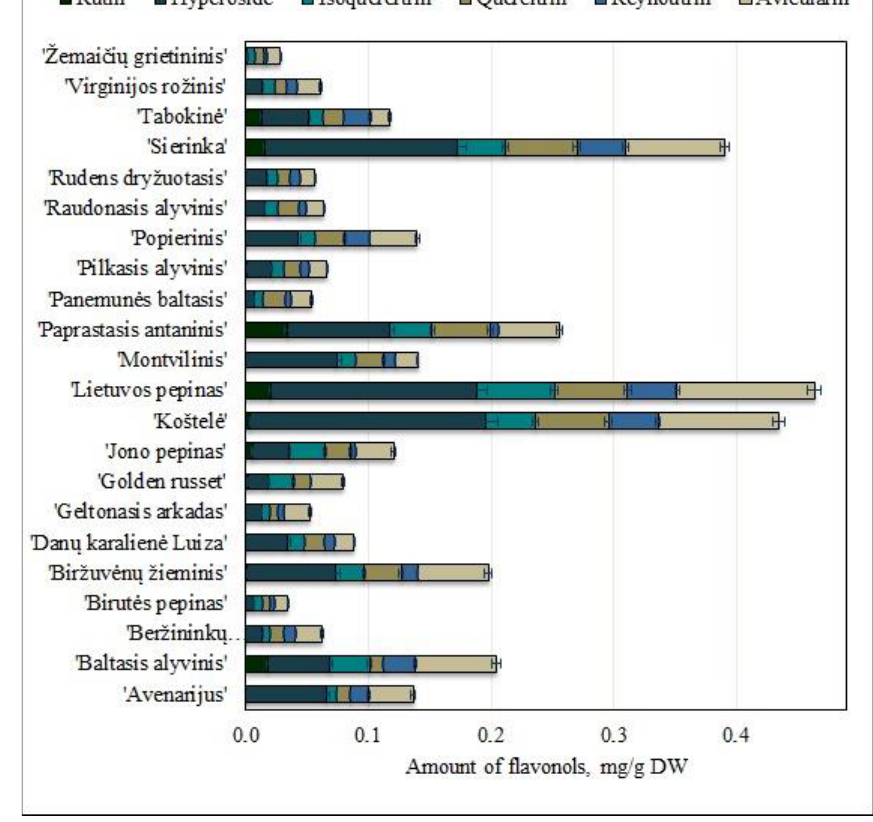
Figure 3 Figure 3. Variability of the amount of flavonols in fruit samples of heirloom apple